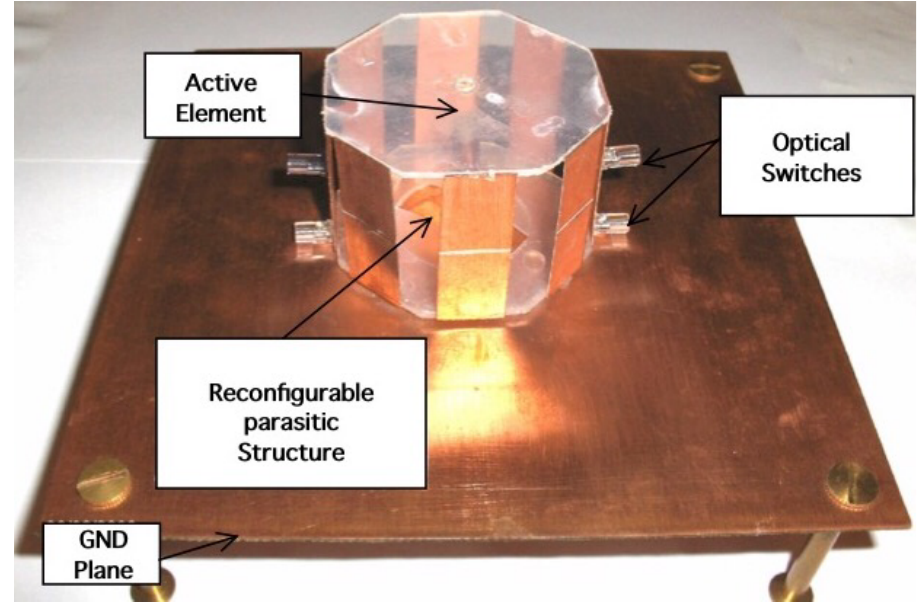
Figure 6. Photograph of the antenna